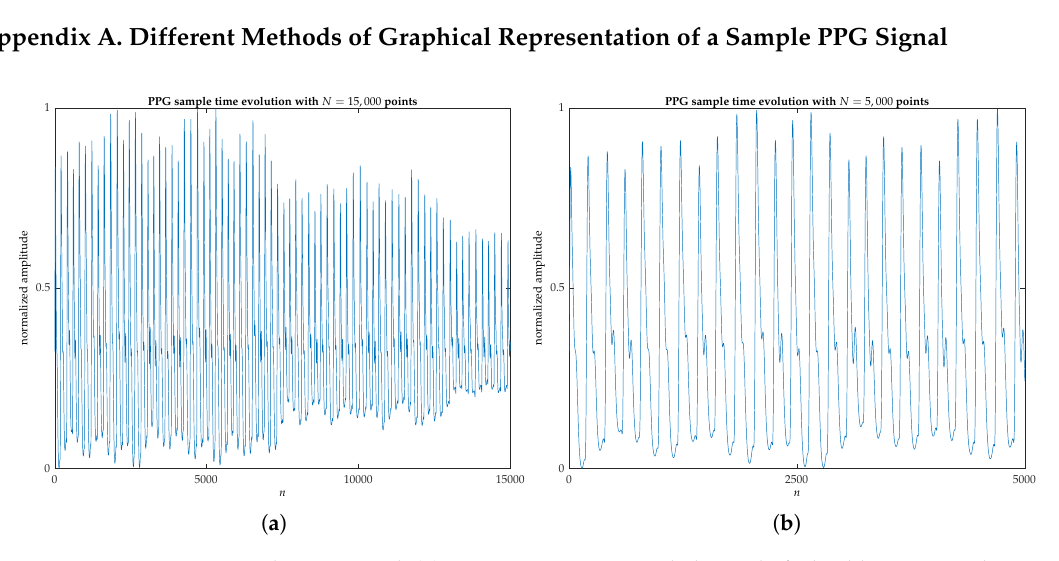
Figure A1. From a sample PPG signal: ( a ) one minute PPG recorded signal of a healthy young subject; ( b ) the first 20 s of ( a ).